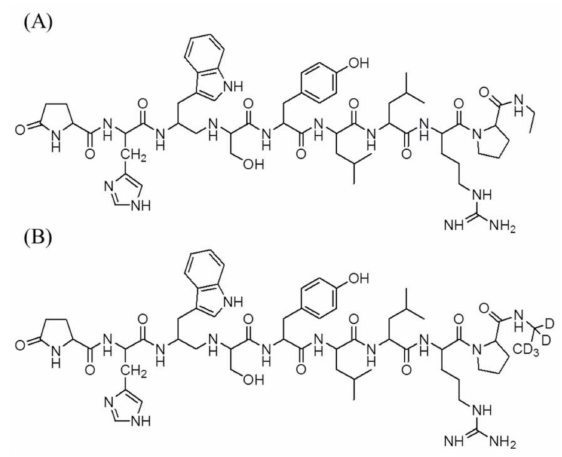
Figure 4. Chemical structures of ( A ) leuprolide and ( B ) leuprolide-d5